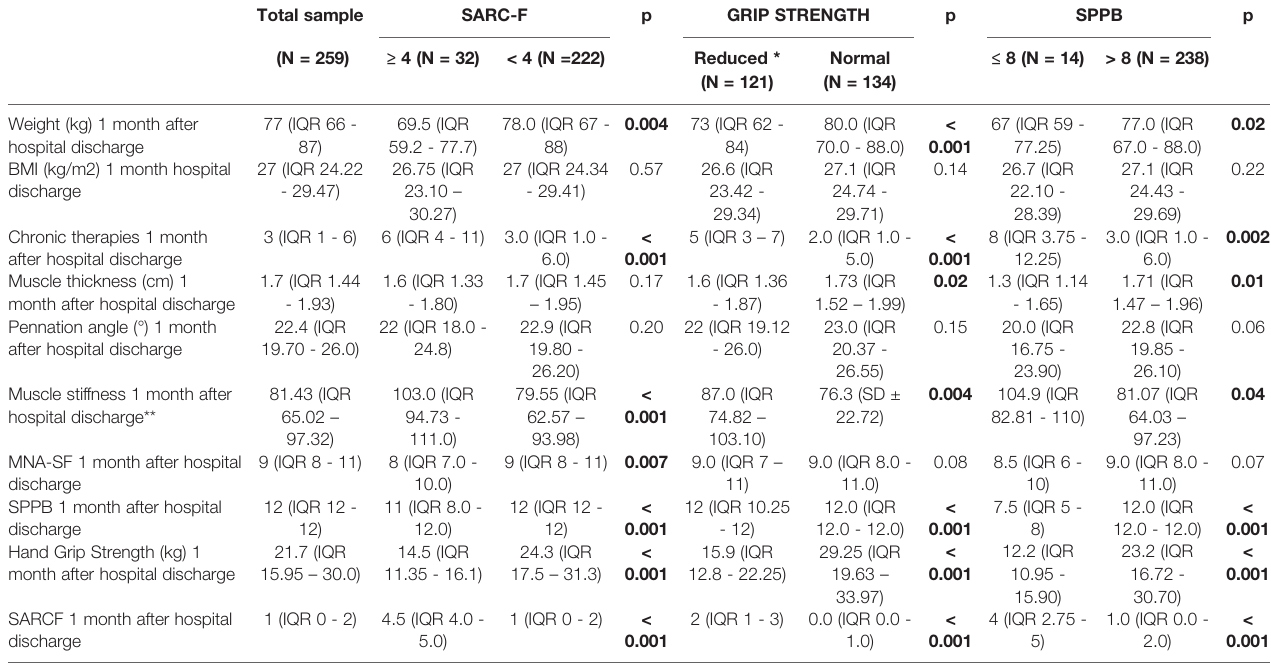
TABLE 3 | Muscle and nutritional characteristics one month after hospital discharge of the study population and their comparison among groups with pathologic and normal values of a sarcopenia screening tool, muscle strength and performance.